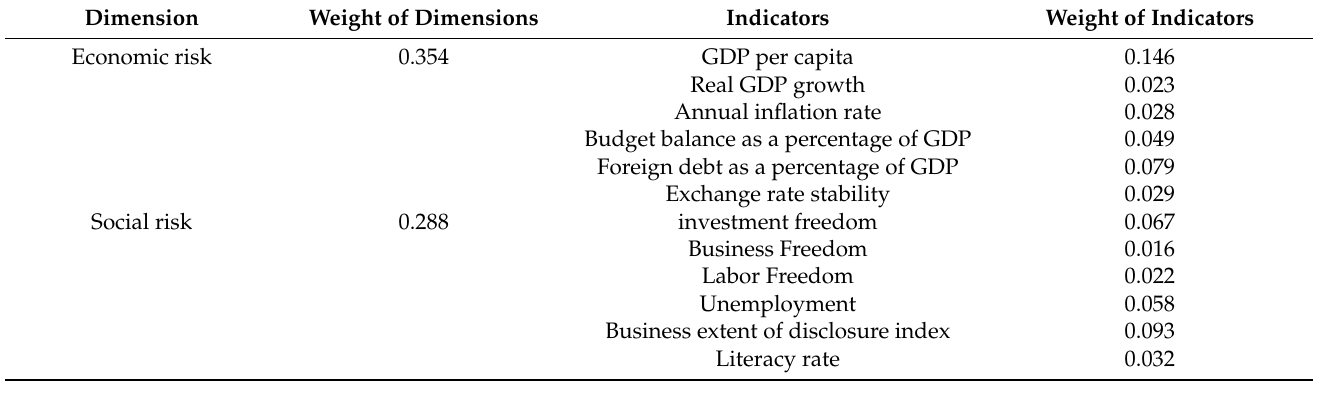
Table 5. Distribution of weights.